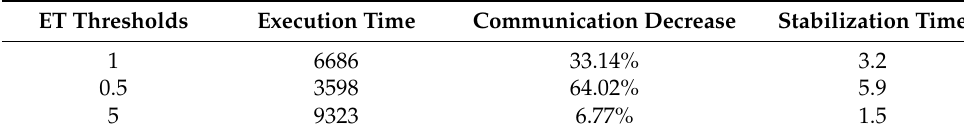
Table 2. Times of execution under different event triggering